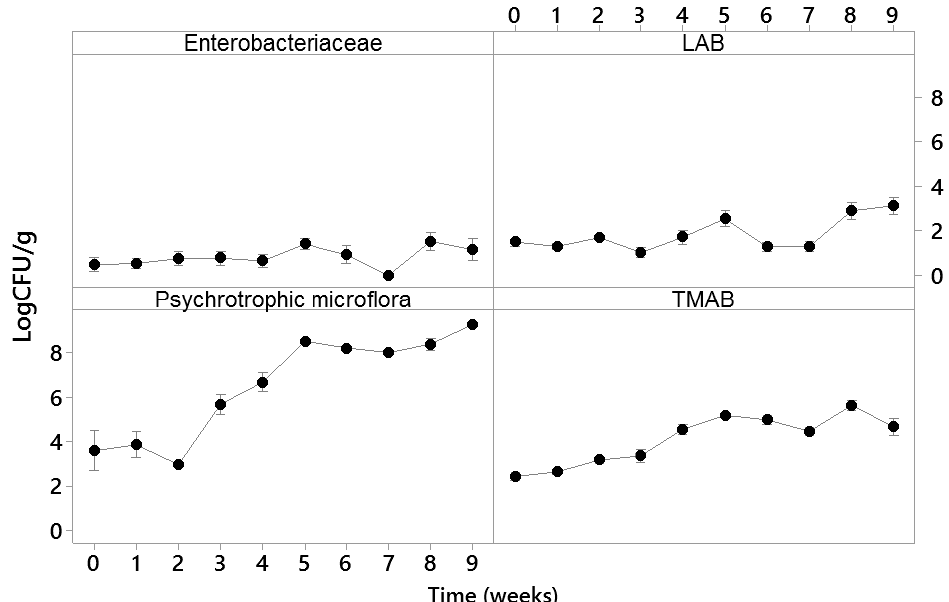
Figure 5. Changes in the microflora in the different VP meats over the nine weeks of their storage. The datapoints represent the mean values for three replicates, the bars represent the standard errors. LAB: lactic acid bacteria; TMAB: total mesophilic aerobic bacteria.